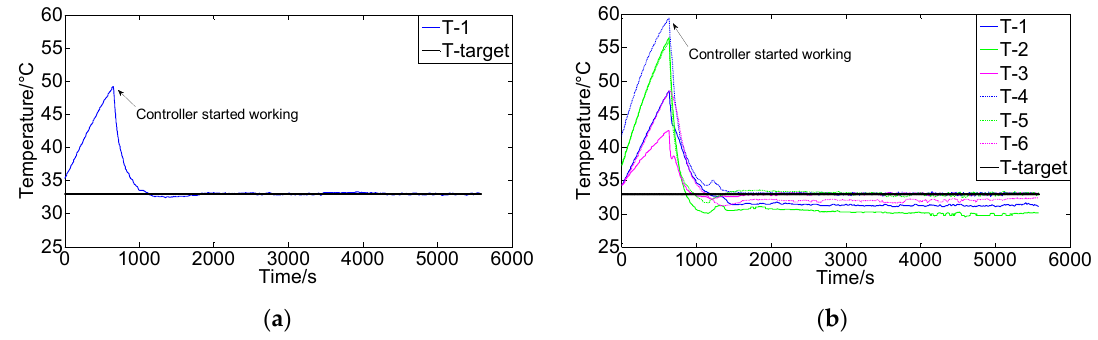
Figure 6. ( a ) Control results of a PIDNN controller for single module; ( b ) Control results of six separate PIDNN controllers for the six modules (Target temperature is 33 °C).